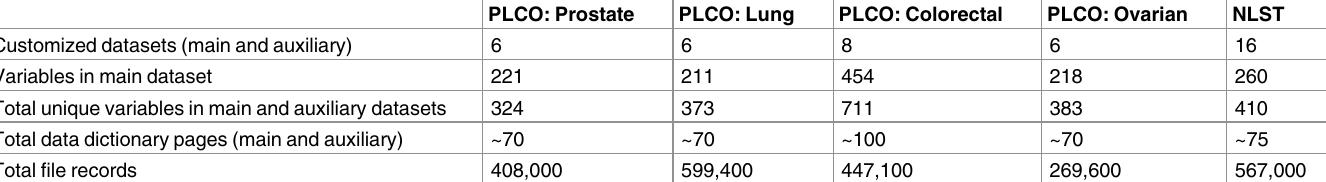
Table 1. Data dictionary